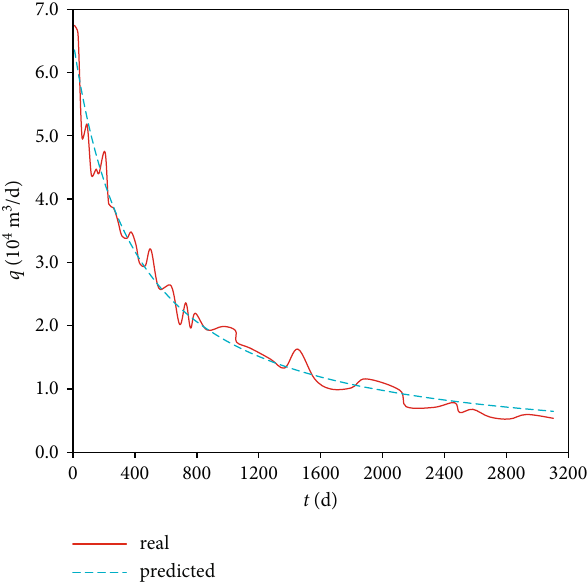
Figure 30: The real q pro fi le and the predicted pro fi le by the hyperbolic decline model for Case 3.